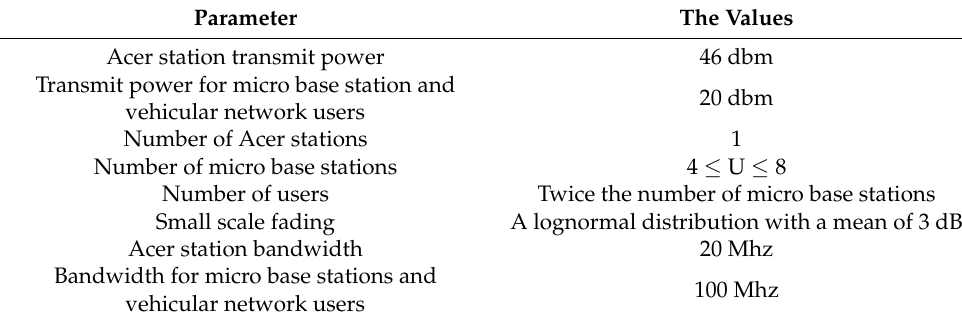
Table 2. Parameter settings.